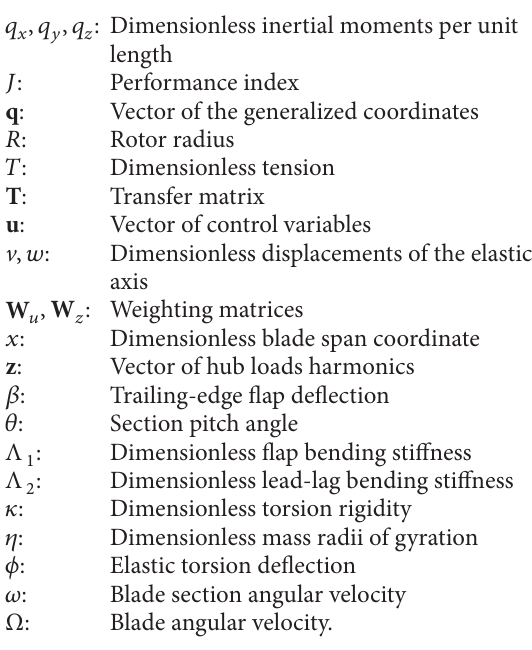
and range of variation of its stiffness is recommended. To conclude, the combined application of smart devices and trailing-edge flap provides promising results, which would deserve further investigations to confirm their effectiveness and feasibility of